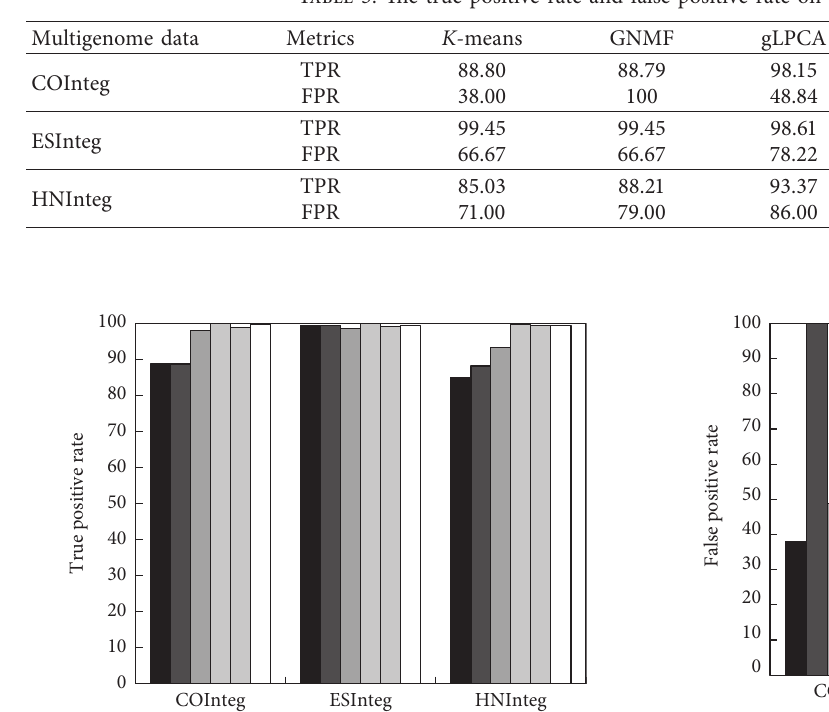
Table 5: The true positive rate and false positive rate on multigenome data.